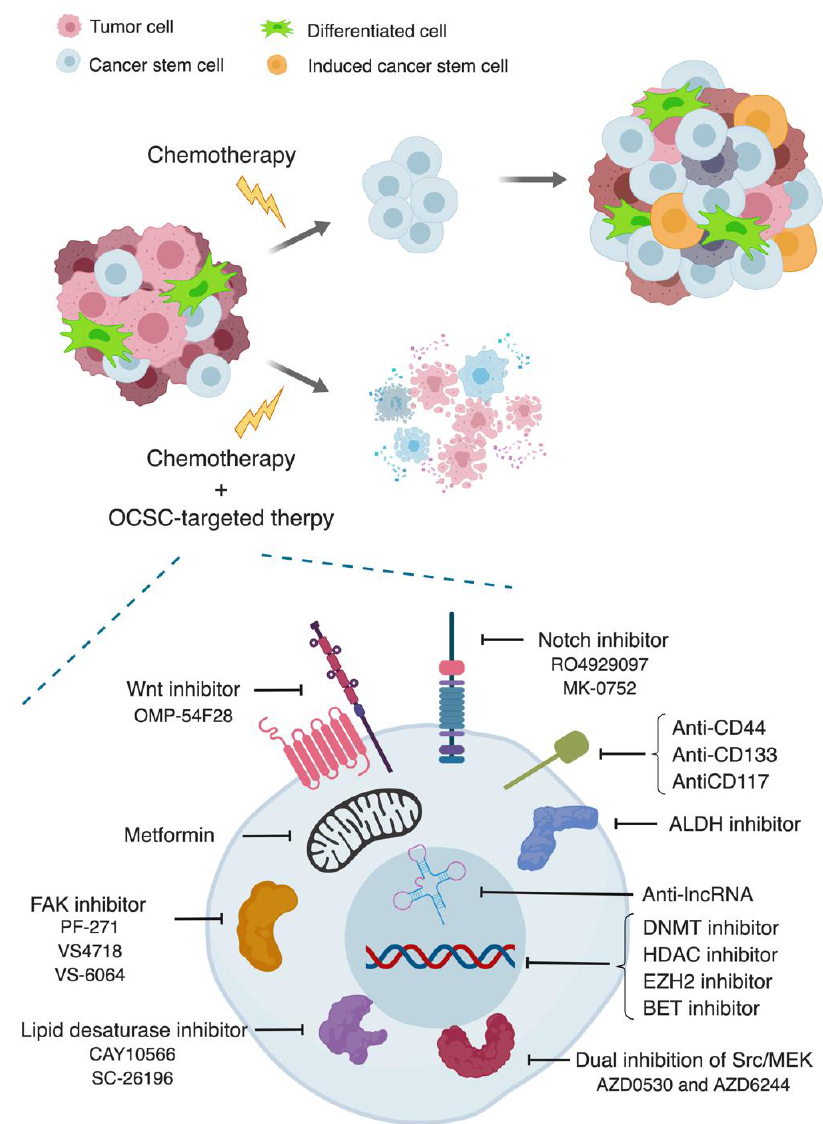
Figure 2. Schematic representation of OCSCs driving recurrent tumors and targeting strategies. Standard chemotherapy eliminates bulk tumor but not OCSC population. The residual tumor is enriched in OCSC population post-chemotherapy, which generates diverse cell population and drives a more aggressive disease. However, combining conventional chemotherapy with selected anti-OCSC therapeutics can ultimately contribute to potential tumor remission .